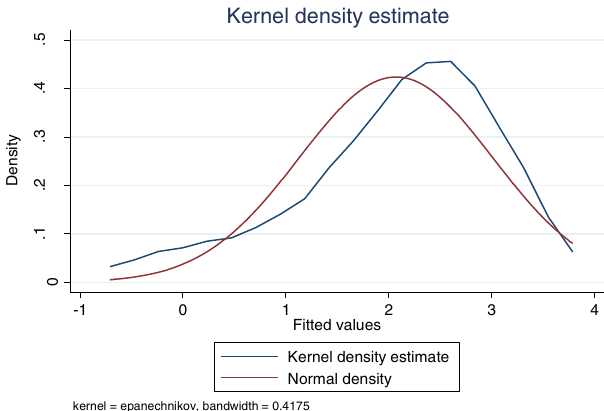
Fig. 3 Kernal density estimate for normality checking of the residual. Authors ’ own calculation.